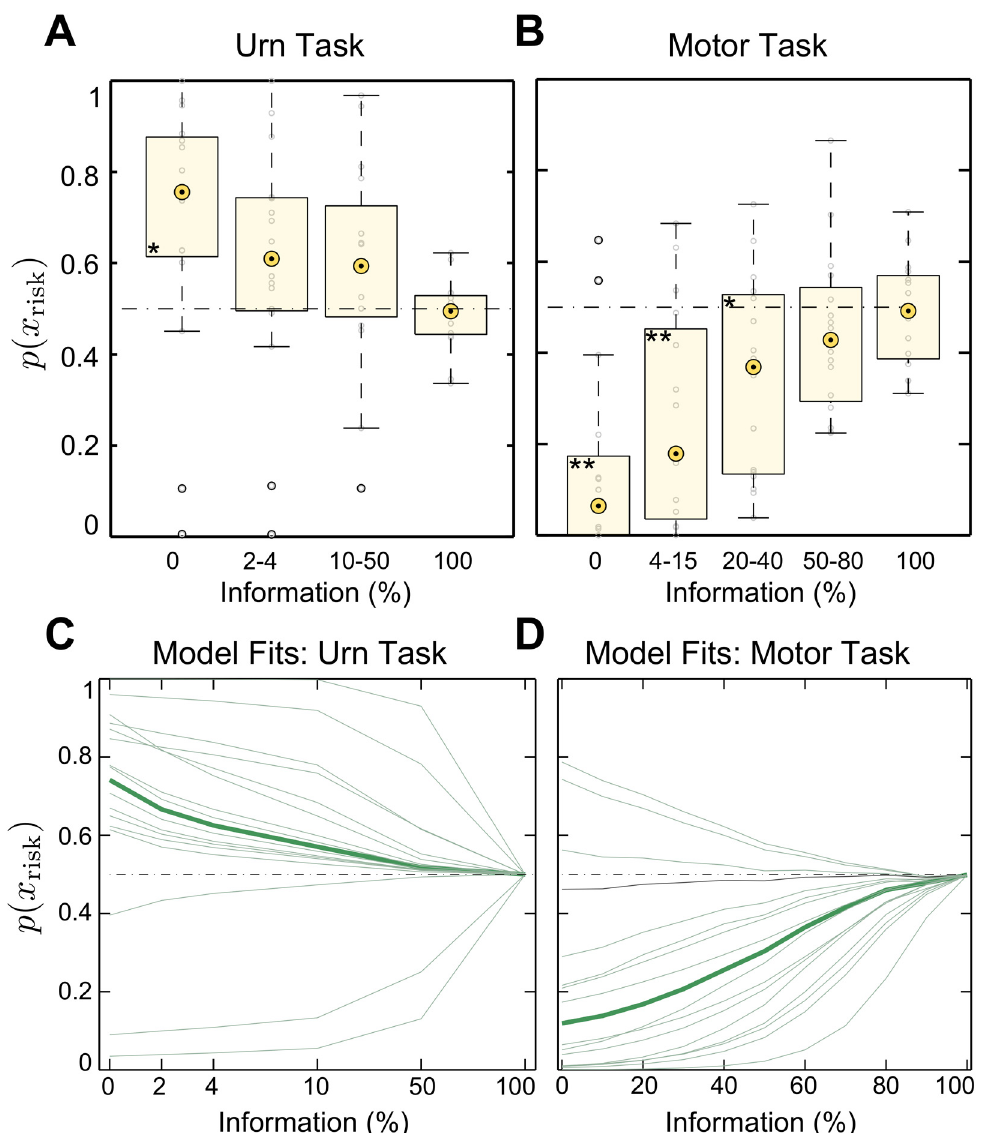
Fig 3. Experiment 1: Experimental data and model fits. Aggregate choice probabilities over all subjects in probe trials of A the urn task, B the motor task. The boxes are centered around the median across subjects and the edges of the box are the 25th and 75th percentiles. Panels C and D show the corresponding model fits. The thin green lines represent individual subjects ’ choice probabilities according to Eq (4), the thick green line indicates the group mean. The dashed lines show the indifference choice probabilities predicted by expected utility. Probabilities above the dashed line imply that subjects prefer the risky choice (ambiguity aversion), probability values below the dashed line imply that subjects prefer the ambiguous choice (ambiguity preference). Asterisks denote significant deviation from the expected utility prediction: one asterisk signifies p < 0.05, two asterisks signify p < 0.01. In the urn task information (%) corresponds to the ratio of the number of revealed balls to the total number of balls, in the motor task and in the urn task with motor stimulus to the ratio of visible size to total size of the ambiguous target.